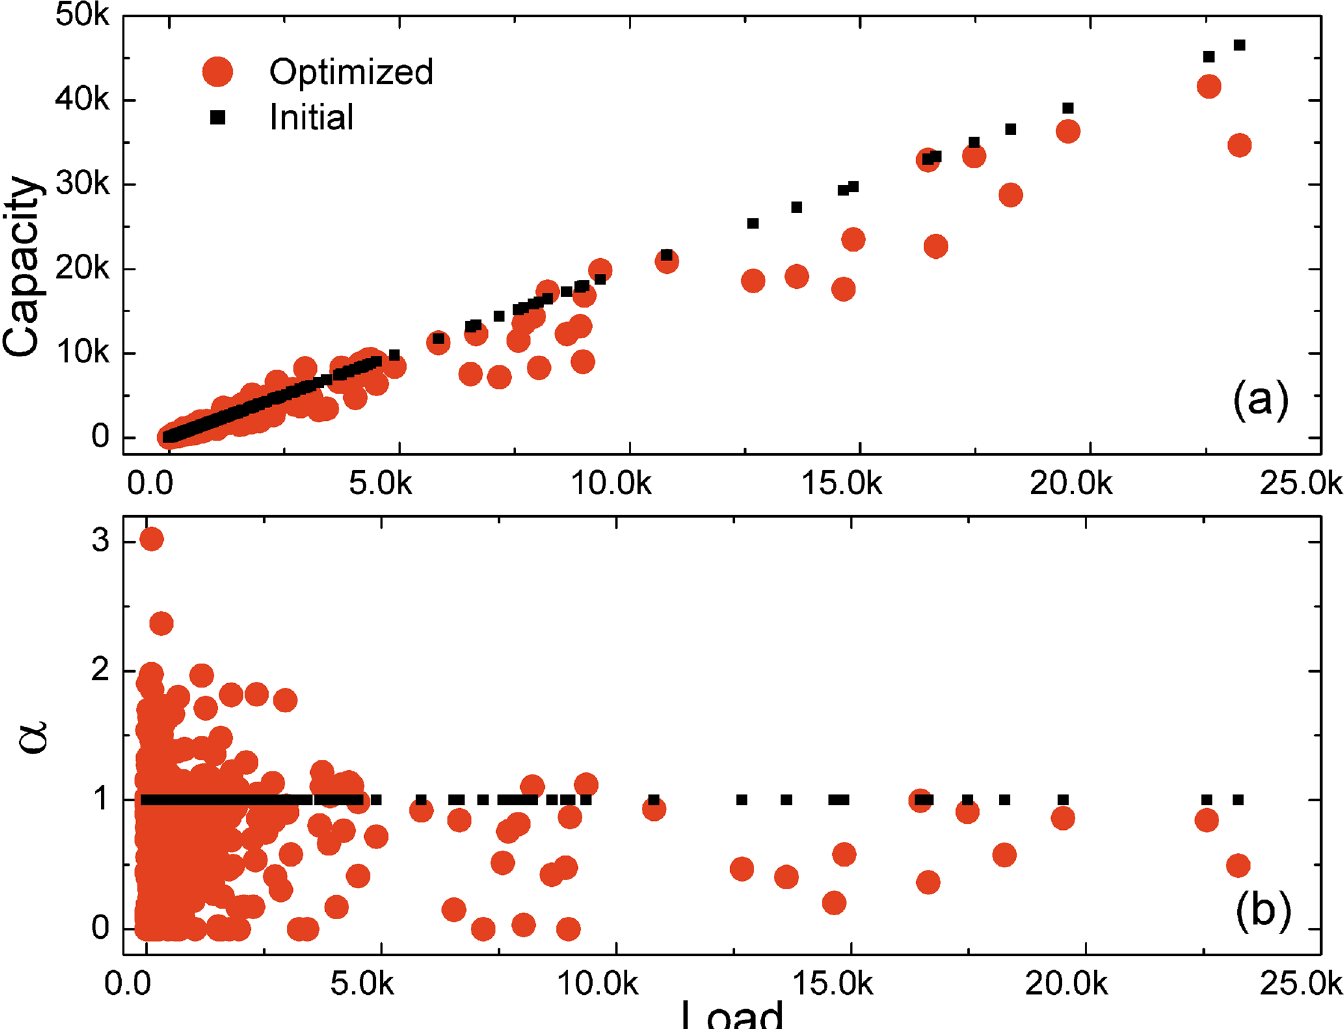
Fig 3. Capacity-load relationship of the network. (a) Node capacity as a function of node initial load. (b) Node tolerance parameter α as a function of node initial load. The adjusting parameter is set to ω = 0.8. The maximum cost λ = 1.0. The algorithm runs for 1,000 iterations each